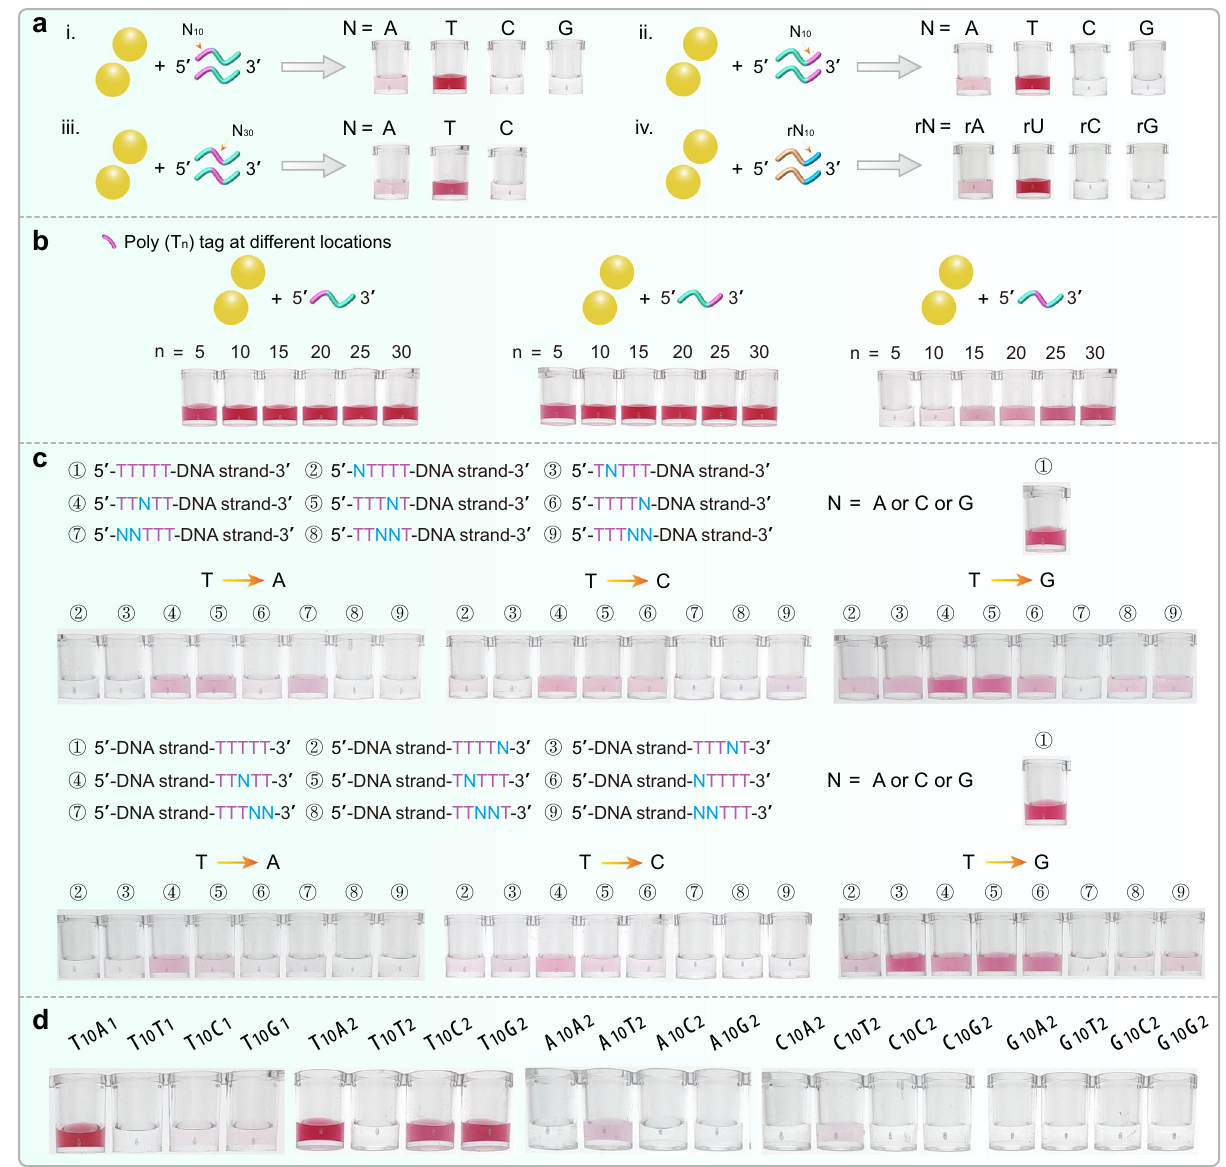
Fig. 2 Poly (T/U) tag-dependent DNA/RNA-AuNP conjugates. a MW-assisted heating-dry labeling of DNA-AuNP and RNA-AuNP conjugates. Photographs showing the labeling results of DNA sequences with poly (T) tag at 5 ′ -terminal (i), 3 ′ -terminal (ii), and in the middle region (iii). Photographs showing the labeling results of RNA sequence with poly (rU) tag at 5 ′ -terminal (iv). An inef fi cient and failed labeling will lead to the AuNPs aggregation. b Photographs showing the labeling results of poly (T)-tagged DNA with different numbers of T base located at 5 ′ -terminal, 3 ′ -terminal and in the middle region. c Photographs showing the labeling results of poly (T 5 )-tagged DNA, in which one or two T bases in T 5 were replaced by A, C, and G base. Poly (T) tags at both 5 ′ - and 3 ′ -terminal are evaluated. d Observation of the poly (T 10 ) dependence and role in the heating-dry labeling